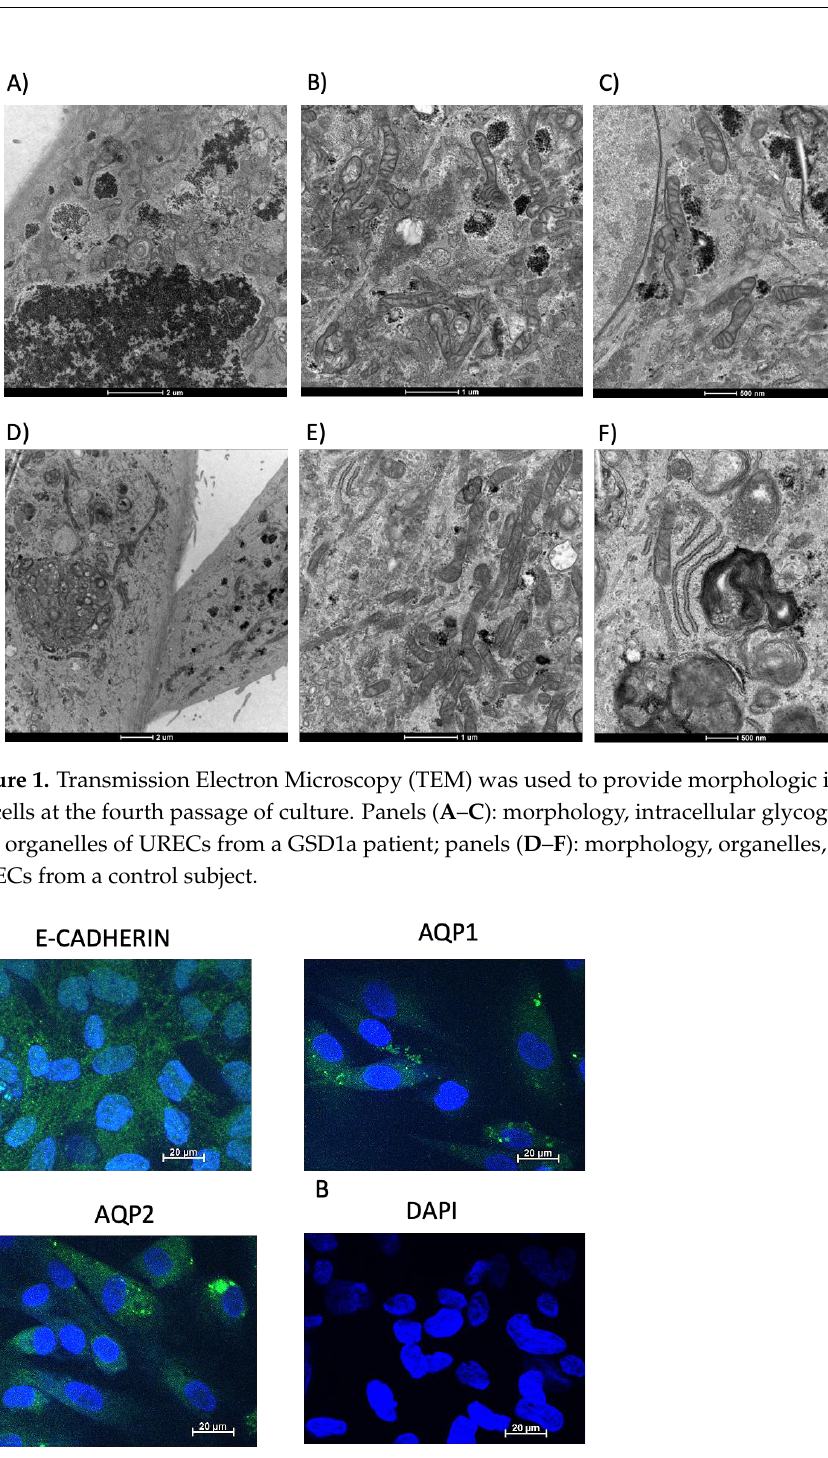
Figure 2. Immunofluorescence microscopy of GSD1a URECs stained with E-cadherin (green, ( A ) panel), an adherens epithelial junctions marker; with Aquaporin-1 (AQP1, green, ( B ) panel), a kidney proximal tubule marker; with Aquaporin-2 (AQP2, green, ( C ) panel), a collecting duct marker. Cell nuclei were counterstained with DAPI (blue, ( D ) panel). Scale bars, 20 µ